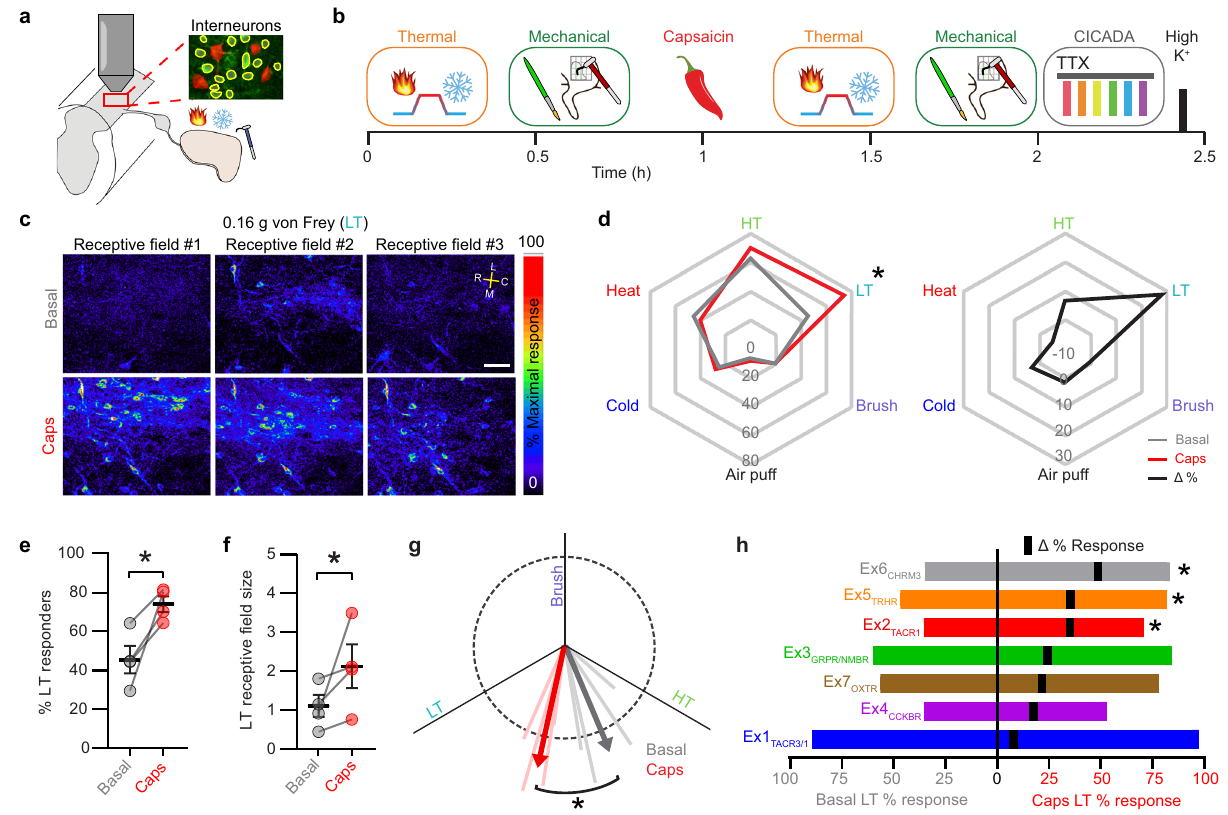
Fig. 6 | Capsaicin injection increases the frequency of LT responsive neurons and enhances LT tuning. a Experimental design. b Experimental protocol for testing the effects of capsaicin induced central sensitization. c Field of view in the super fi cial SDH showing maximum Δ F/F responses during LT stimulation at 3 RFs before and after intradermal injection of capsaicin (scale bar, 50 µ m). N =4 animals. d Left:radarchartshowingthepercentofexcitatorycellsresponsivetotheindicated stimuli before (grey) and after capsaicin (red). Right: change in percent responders. Therewasasigni fi cantmaineffectofstimulation( F (4,12)=41.11), P <0.0001,anda signi fi cant interaction between stimulation and time ( F (4,12) = 5.176), P =0.0117 (2- way RM ANOVA). Post hoc testing was performed comparing post/pre capsaicin for allstimulations. N =4mice,* Q <0.05 e PercentofallexcitatorycellsresponsivetoLT stimulation before/after capsaicin. N=4 animals. * Q <0.05. Data are presented as meanvalues±SEM. f LTRFsizeofexcitatorycellsbefore/aftercapsaicin.Corrections for both LT and HT were included (HT data shown in Supplementary Fig. 8). There wasasigni fi cantinteractionbetweenstimulationandtime( F (1,3)=13.34), P =0.0354